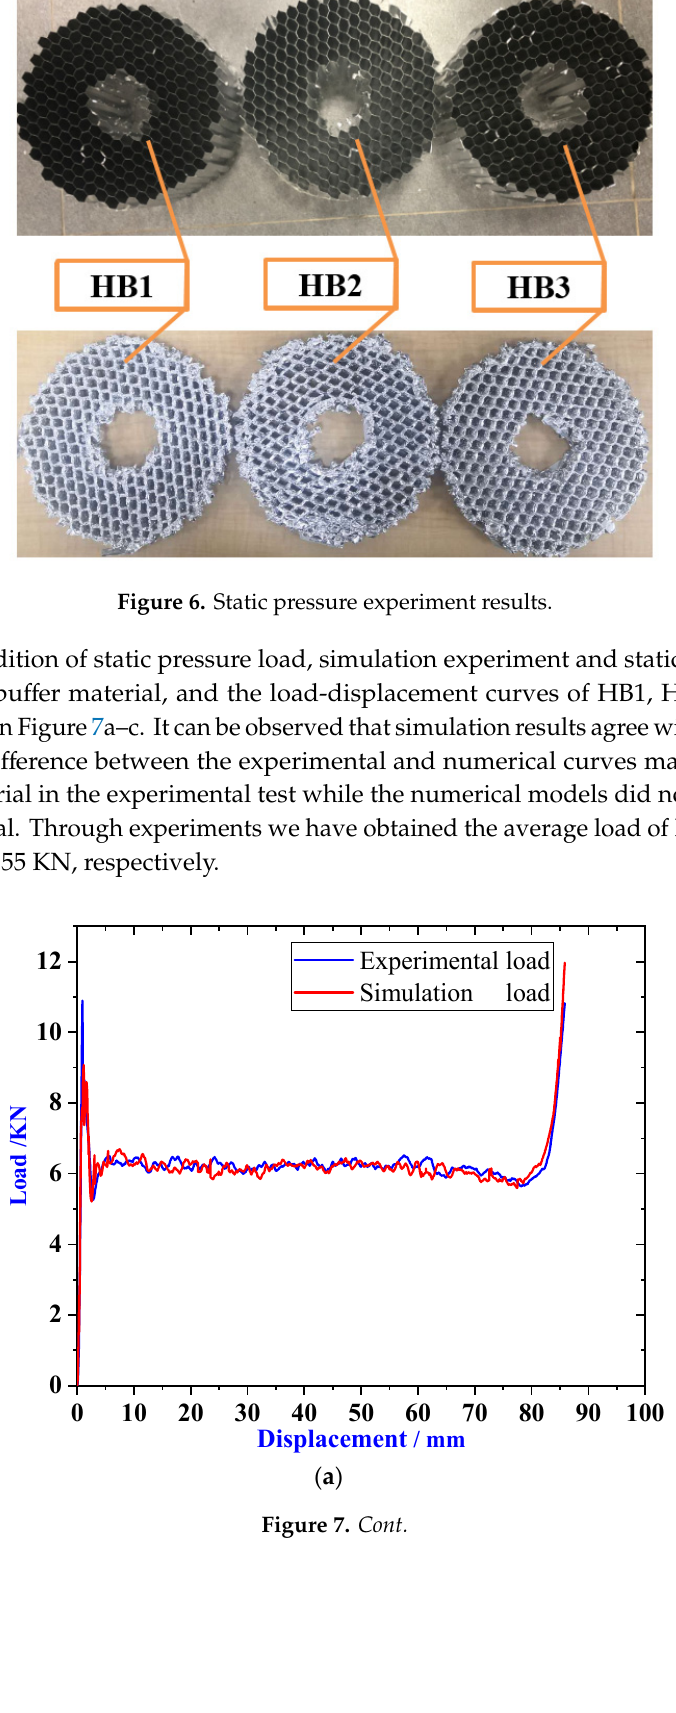
Figure 6. Static pressure experiment results. Table 2. Experiment compression ratio.